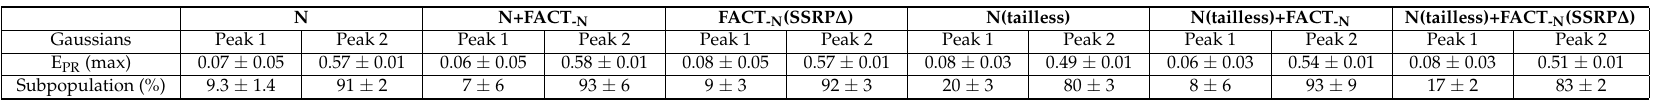
Table 1. Positions of E PR maxima and distribution of nucleosomes between two subpopulations as measured by spFRET microscopy for intact and tailless nucleosomes as well as for their complexes with FACT and FACT (SSRP ∆